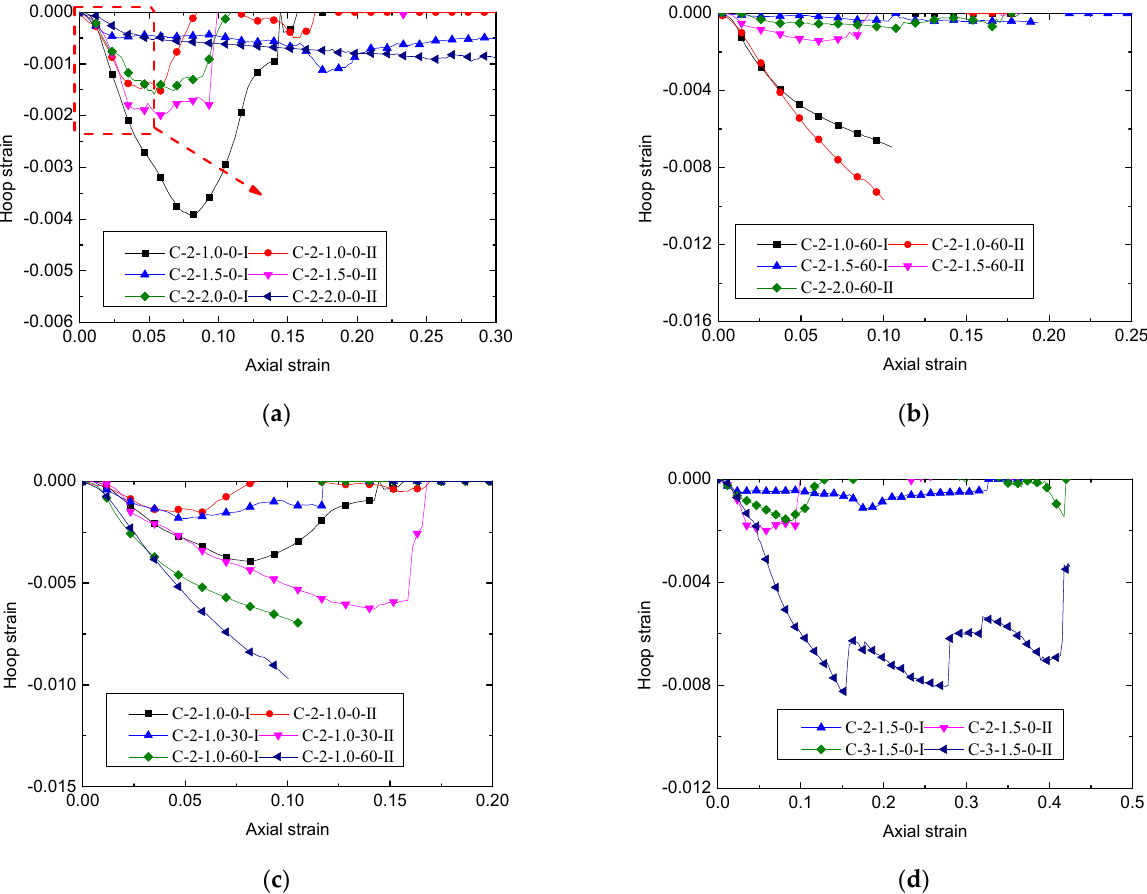
Figure 11. Hoop strain-axial strain curve of CSBM specimens:( a ) Series 1; ( b ) Series 2; ( c ) Series 3; ( d ) Series 4.